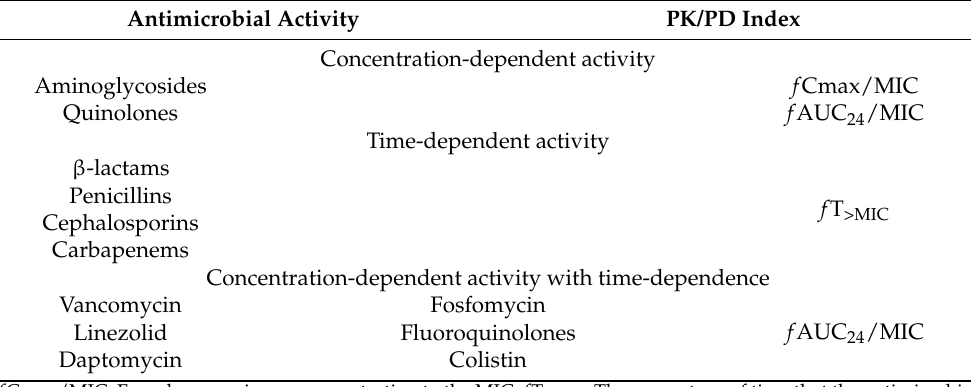
Table 1. PD indices related to the efficacy of different